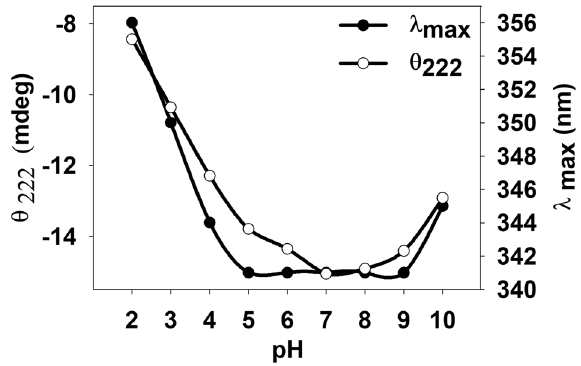
Figure 6. Effect of pH (2.0–10.0) on secondary and tertiary structure of hPrdx6. The effect of change in pH from 2.0 to 10.0 on the secondary and tertiary structure of hPrdx6 determined using Far-UV CD, and Near-UV CD is indicated by plotting the change in ϴ 222 and λ max with escalation of pH 2.0 to 10.0 by the unit of